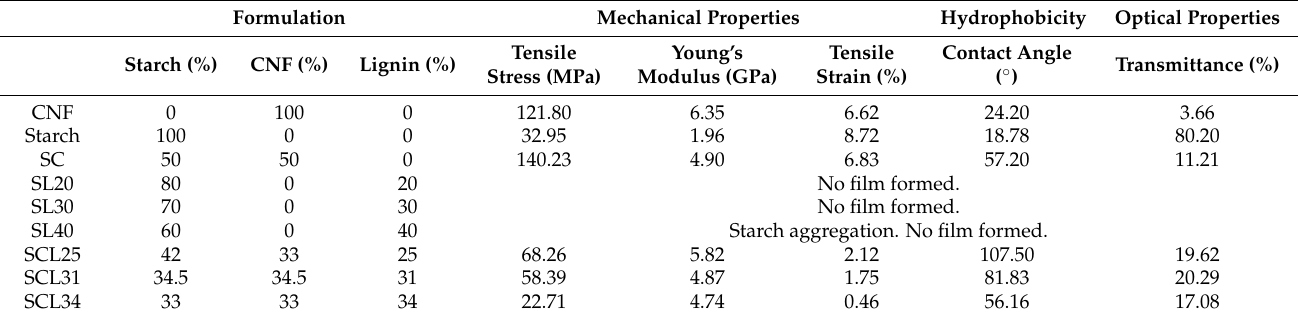
Table 1. Formulation and characterization of neat and composite films made of starch, CNF and lignin.